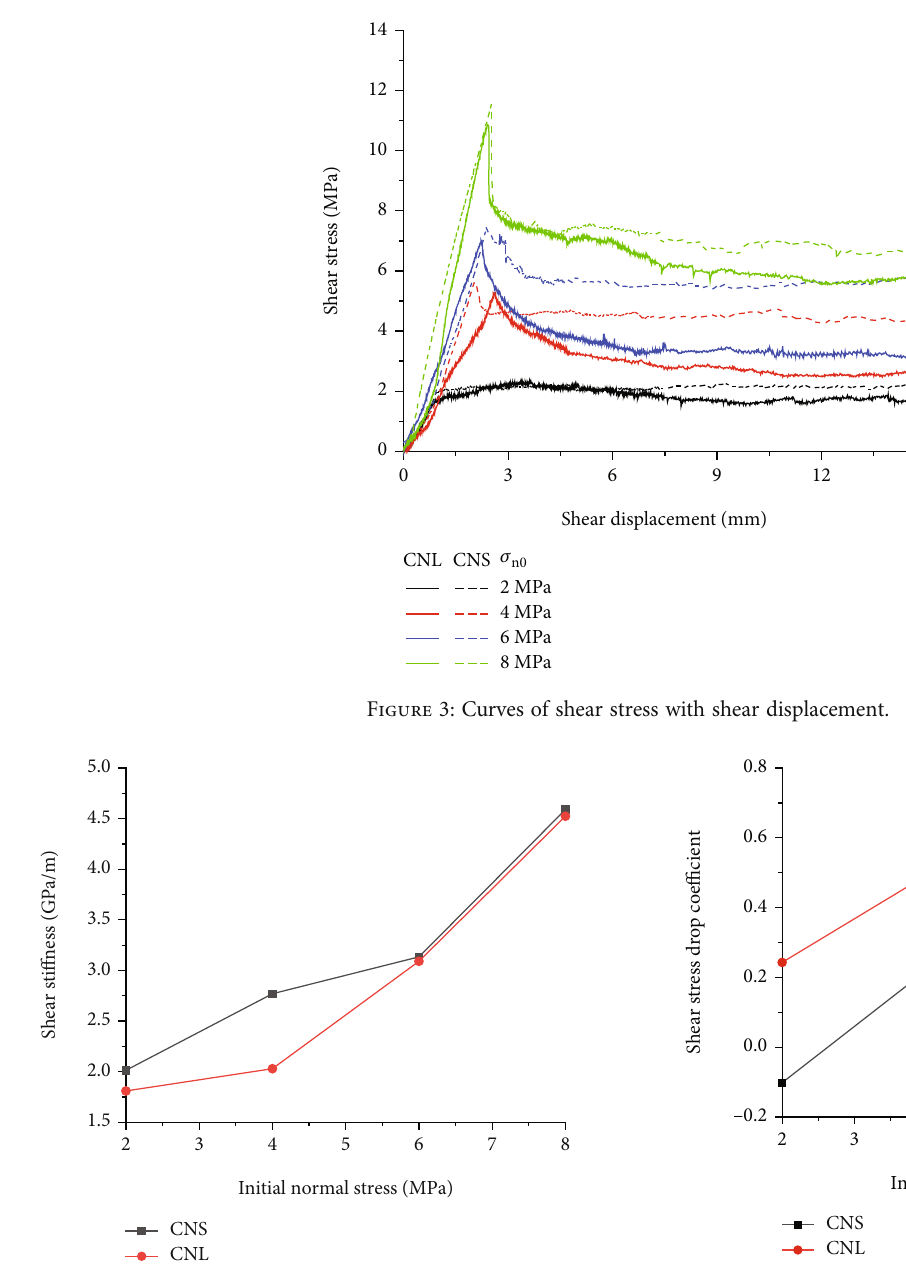
Figure 4: Curves of shear sti ff ness with initial normal stress. Figure 5: Curves of shear stress drop coe ffi cient with initial normal